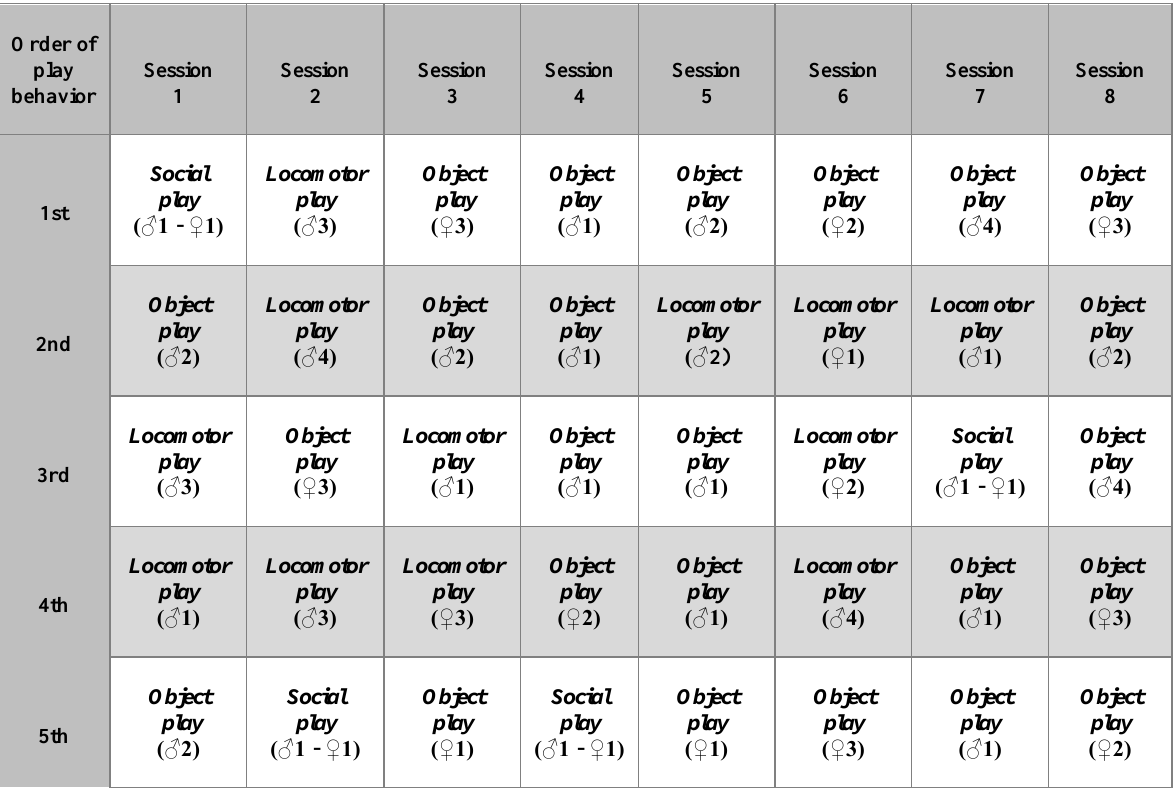
The First Five Play Behaviors in Each Session Performed by a Non-focal Bird. The number after the gender signifies the group rank of the bird within its gender; all males are dominant over all